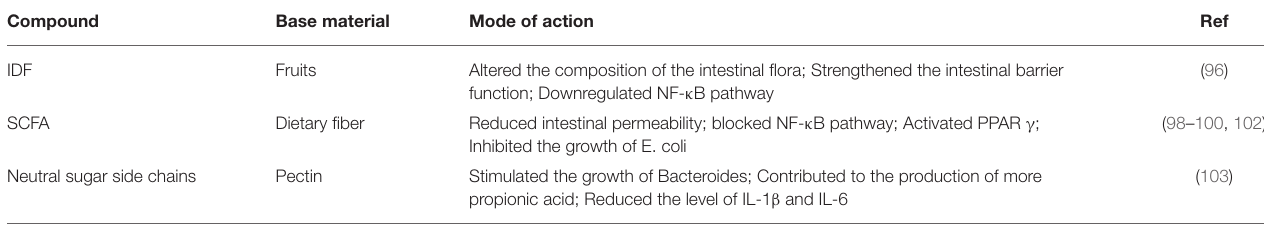
TABLE 2 | Effect of dietary fiber on anti-inflammatory bowel disease.